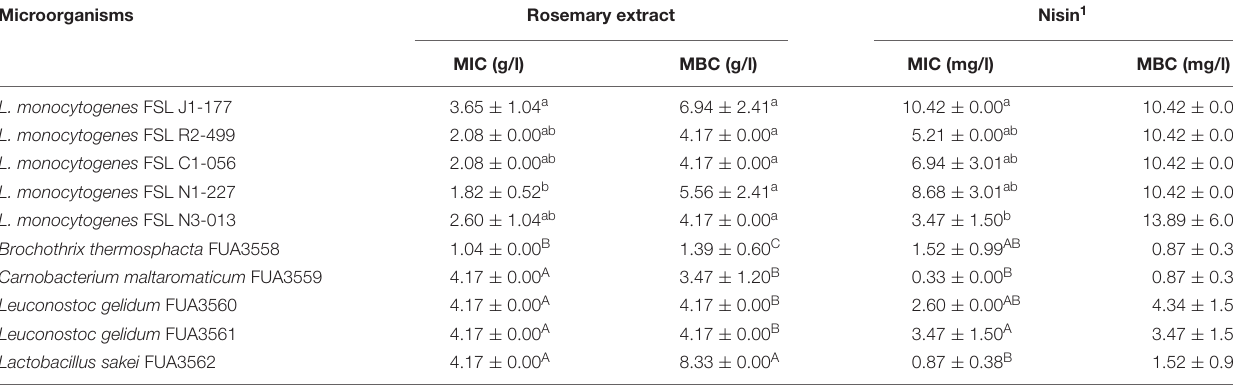
TABLE 1 | MIC and MBC of nisin and rosemary against L. monocytogenes and RTE meat microbiota. Microorganisms